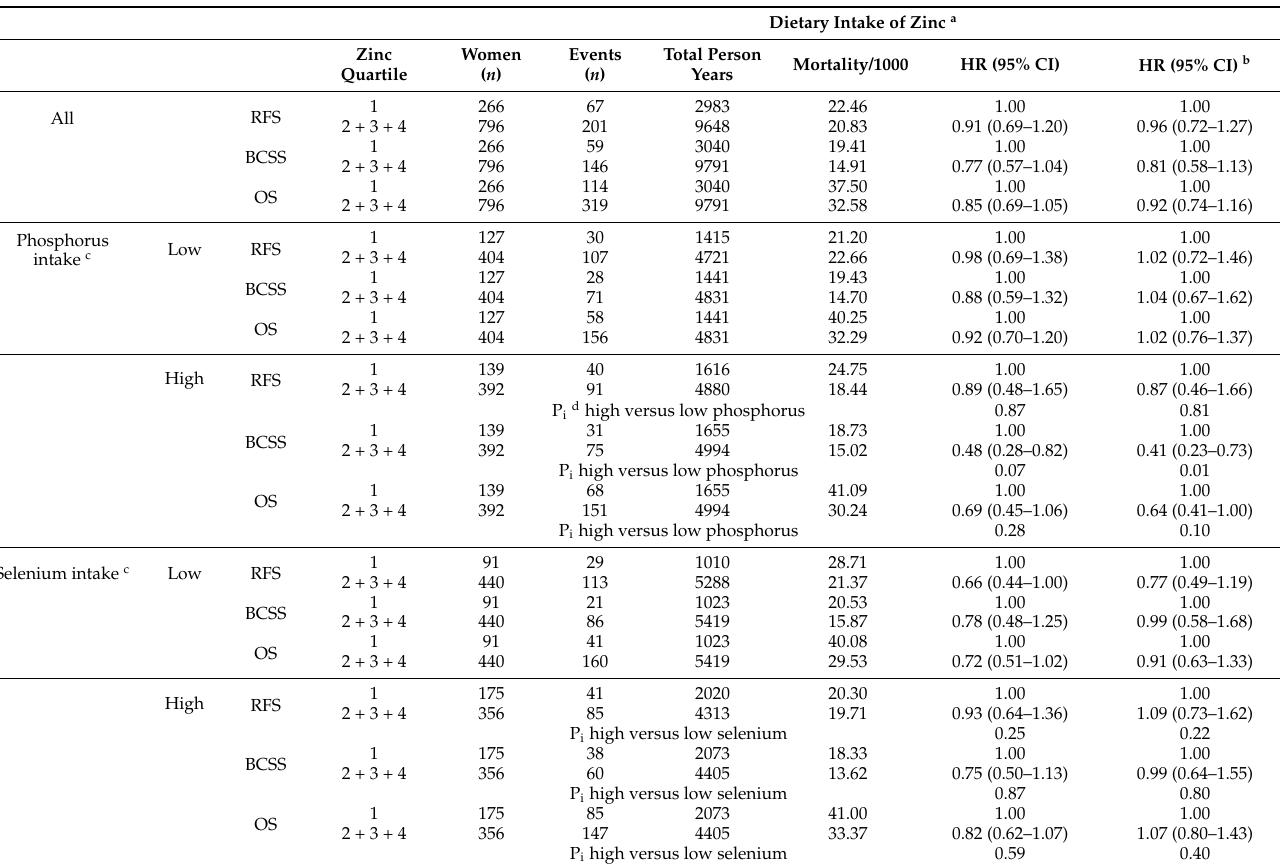
Table 4. Zinc intake in relation to recurrence-free survival (RFS), breast cancer-specific survival (BCSS) and overall survival